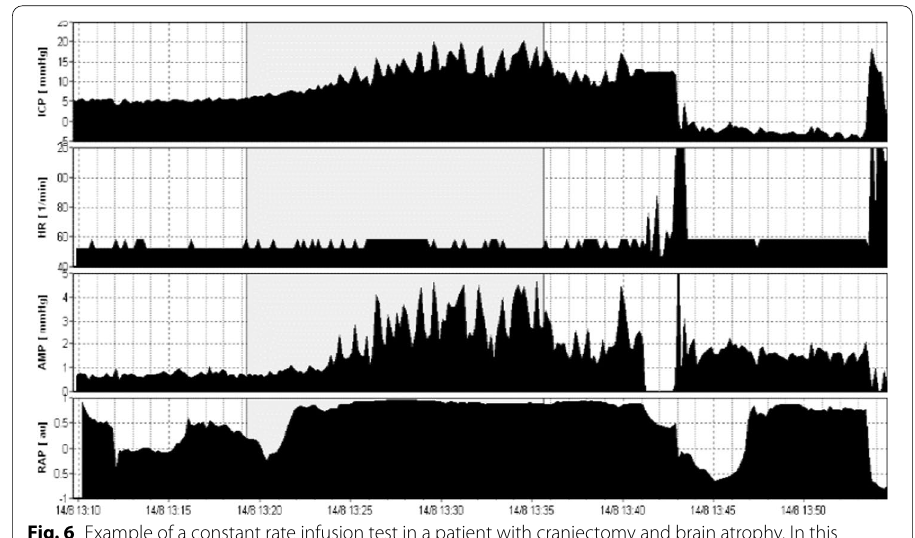
Fig. 6 Example of a constant rate infusion test in a patient with craniectomy and brain atrophy. In this post-craniectomy, post-SAH patient, baseline and plateau pressures during infusion test (gray area) are normal (5.33 and 15.45 mmHg, respectively). Resistance R to CSF outflow is low (7.61 mmHg but there are some B waves in the tracings of both ICP and AMP (pulse amplitude). Nevertheless, their energy and duration are lower in relation with cases of disturbed CSF circulation. This patient does not need any shunt. RAP index is close